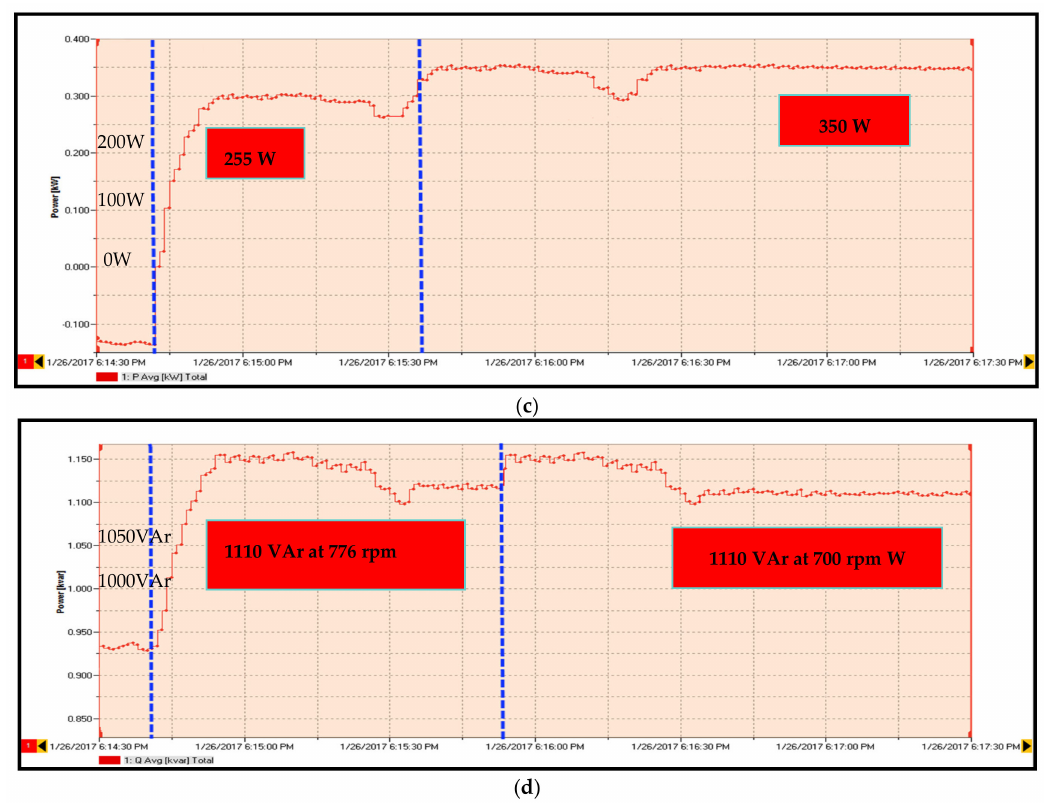
Figure 19. Grid side experimental waveforms for load test (2): ( a ) speed equivalent voltage (V), ( b ) phase A grid voltage and current, ( c ) grid active power (W) [ Y-axis: 50 W / div, X-axis: 15 s / div ], and ( d ) grid reactive power (VAr) [ Y-axis: 25 VAr / div, X-axis: 15 s / div